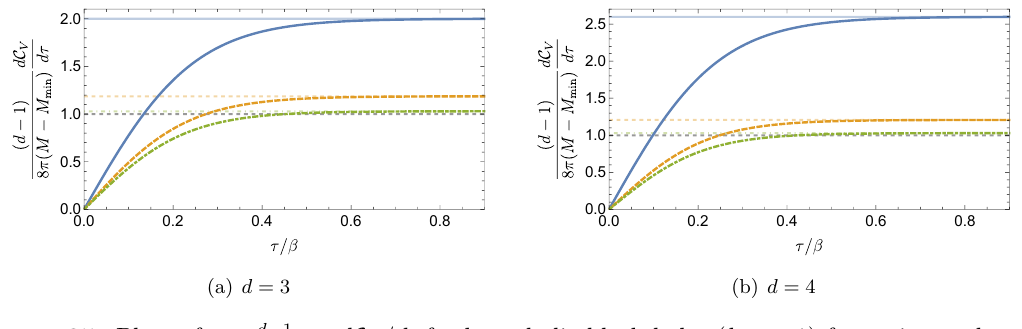
Figure 25 . Plots of d (cid:0) 1 d C V =dt for hyperbolic black holes ( k = (cid:0) 1) for various values of 8 (cid:25) ( M (cid:0) M min ) the horizon radius | r h =L = 1 (blue), r h =L = 2 (yellow), r h =L = 5 (green). Recall that M min was introduced to avoid divergences as the mass takes both positive and negative values, see eq. (3.24) and the explanation above it. The asymptotic values at late times are greater than 1 for small black holes and approach to 1 for large black holes. The asymptotic value is always approached from below.